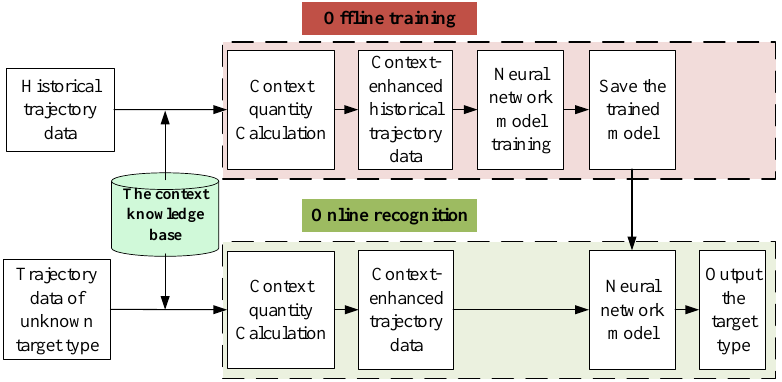
Figure 1. Overall process of the proposed method .